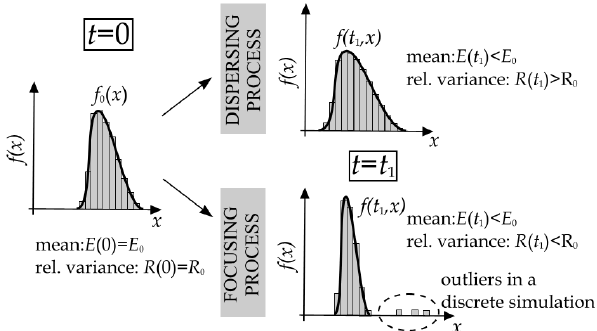
Figure 2. Schematic description of the evolution of mass distri- bution of a pebble population: in a dispersing process the relative size variation R ( t ) of the mass distribution, either represented by an empirical histogram (Carr, 1969) or a continuous function ( f 0 ( x )) at t = 0, increases. In the continuum model of a focusing process R ( t ) decreases as time evolves; however, in a discrete model with a finite number of particles some outliers appear (indicated by dashed ellipse) with mass substantially above the average. The reduced dis- tribution (without the outliers) produces a decreasing relative vari- ance, analogous to the continuous